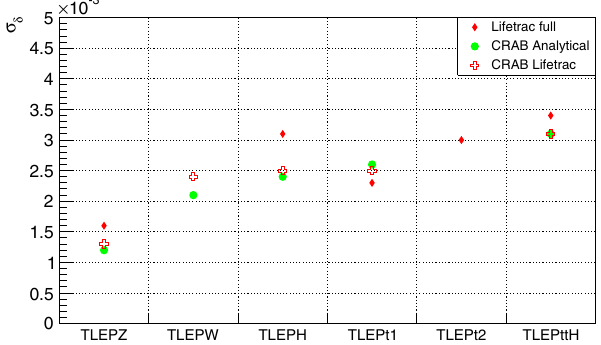
FIG. 7. Beam lifetime for different scenarios of TLEP oper- ation. Red diamonds and red empty crosses are L IFETRAC simulations with full spectrum of beamstrahlung for Tables I and II, correspondingly; green dots are analytical calculations for the latter case.